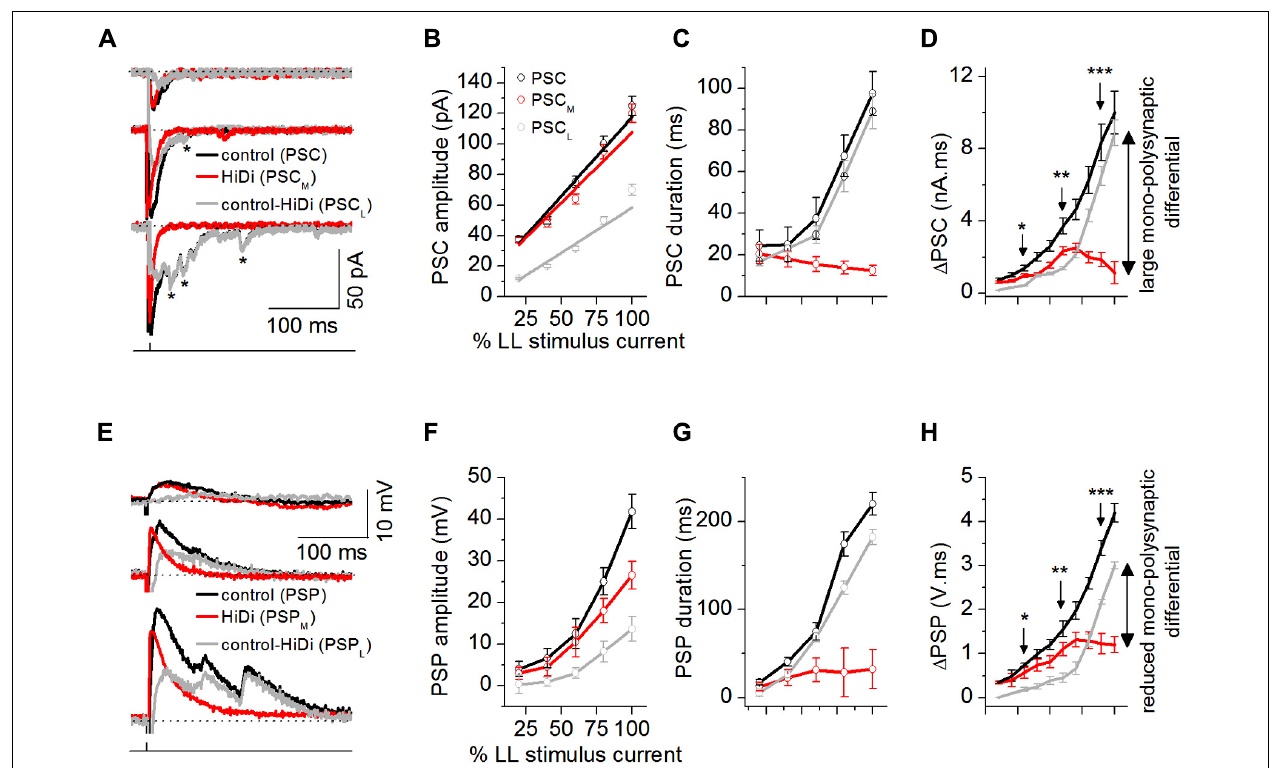
FIGURE 4 |Afferent input recruits distinct synaptic pools. Dynamic ranges of the responses to mono- and polysynaptic inputs were